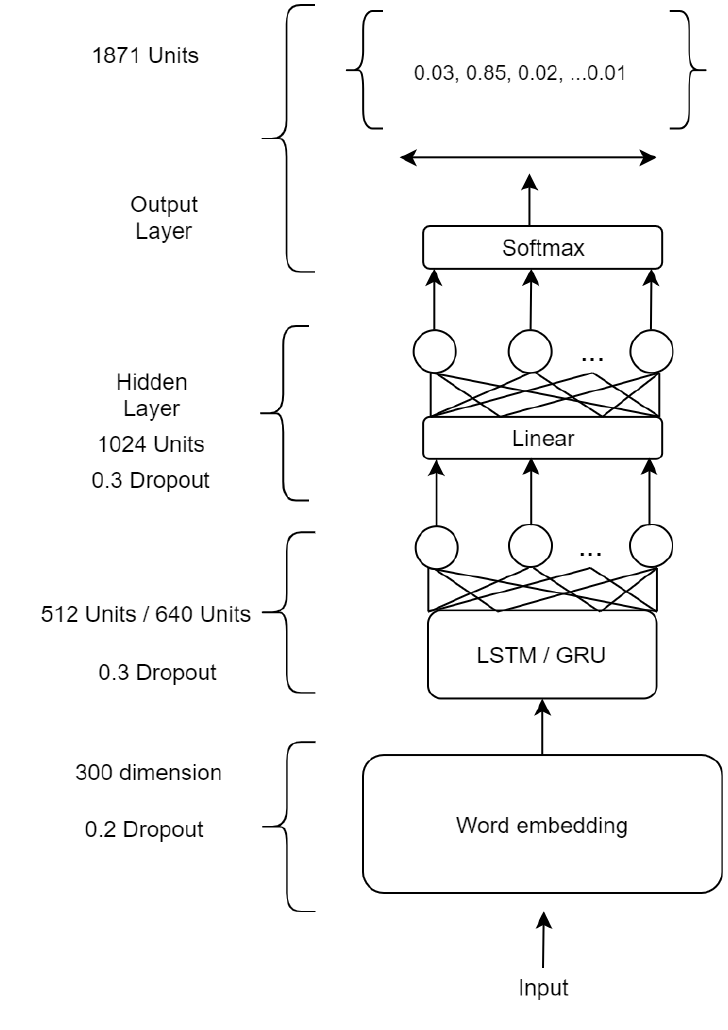
Figure 4. The architecture of our